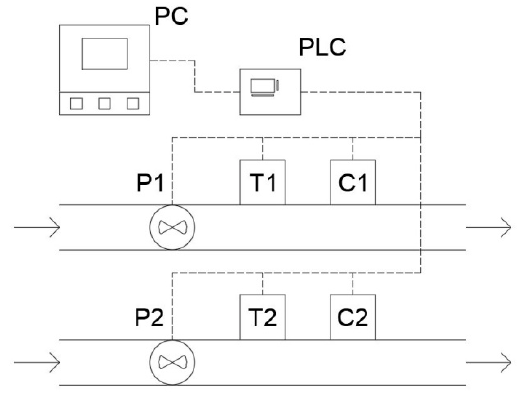
Figure 5. Scheme of the operating measuring system.